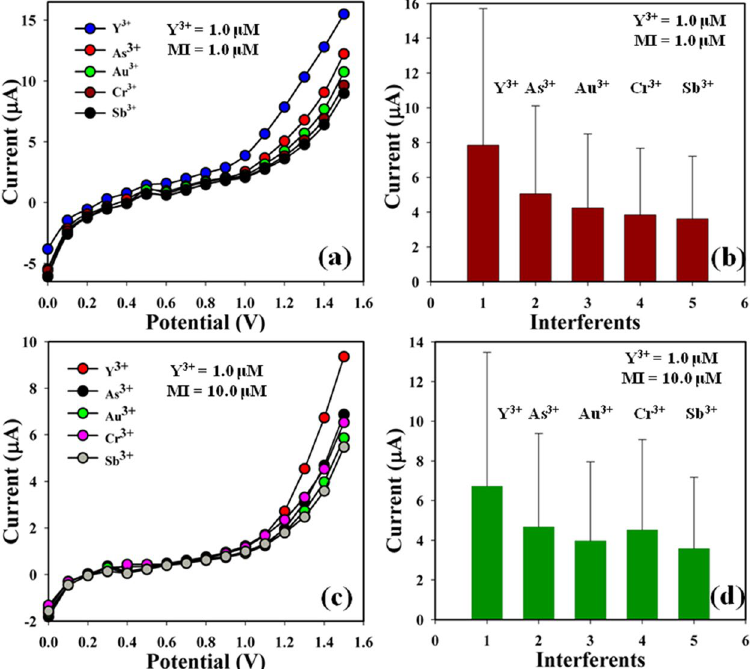
Figure 10. ( a – c ) Interference effect investigation and ( b – d ) bar diagram presentation of IE at + 1.2, and + 1.4 V